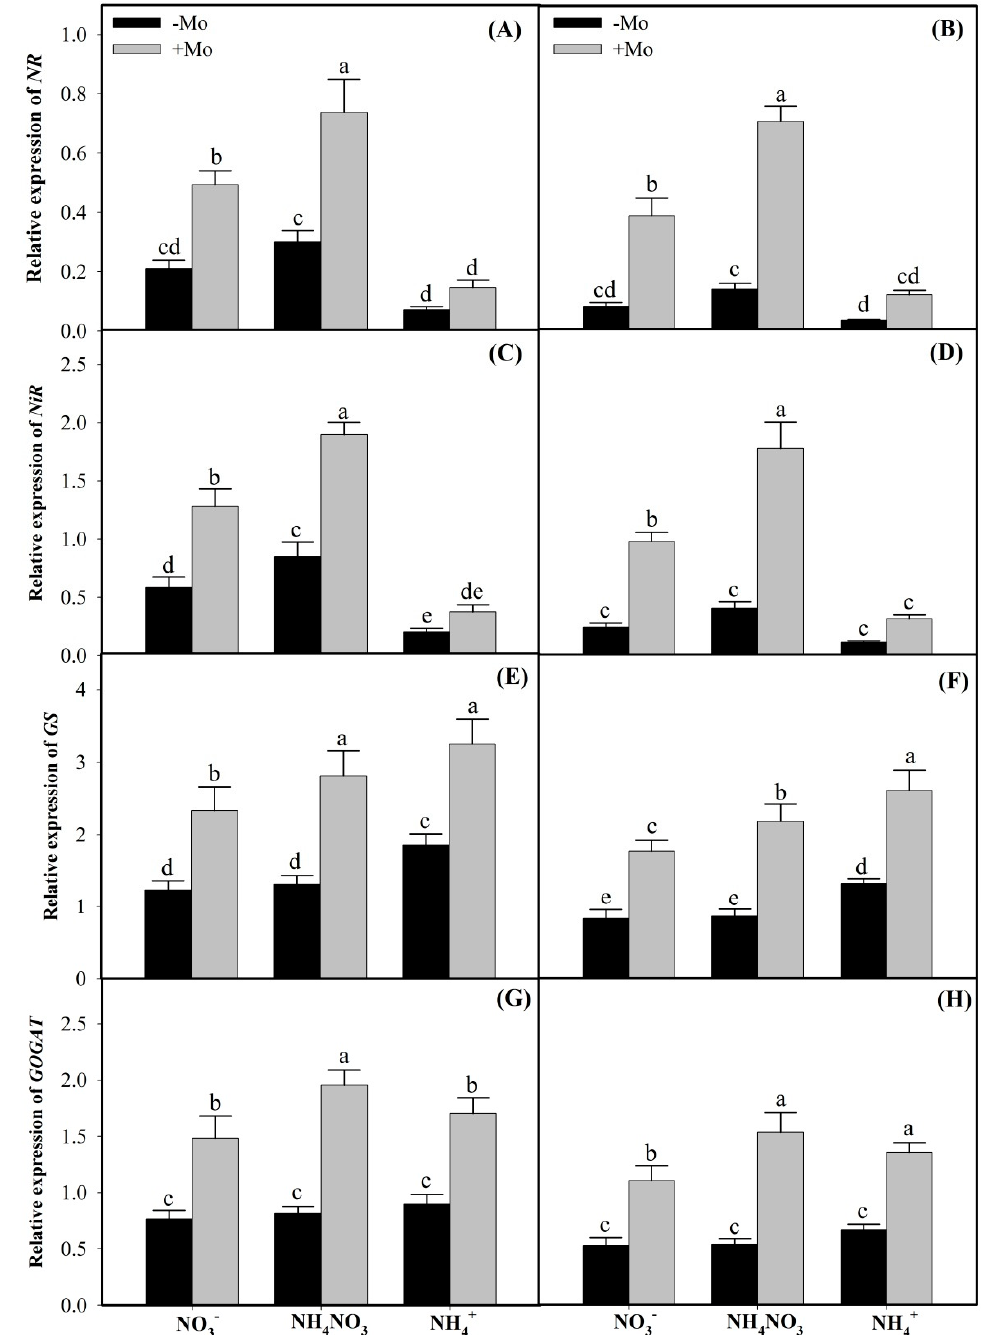
Figure 3. qRT-PCR analysis of NR, NiR, GS, and GOGAT genes transcripts in the leaves of Mo-efficient ‘97003’ ( A , C , E , G ) and Mo-inefficient ‘97014’ ( B , D , F , H ) winter wheat cultivars. Seedlings were grown in nutrient solutions supplied with or without Mo fertilizer [Na2MoO4.2H2O] under different N sources. − Mo and +Mo treatments represent the 0 and 1 µM Mo concentrations, respectively, in Hoagland solution. Vertical bar above indicates standard error of four replicates. Different lowercase letters (a, b, c, etc.) represent significant differences according to the LSD-test ( p < 0.05, n = 4). Description of treatments is mentioned in Figure 1.